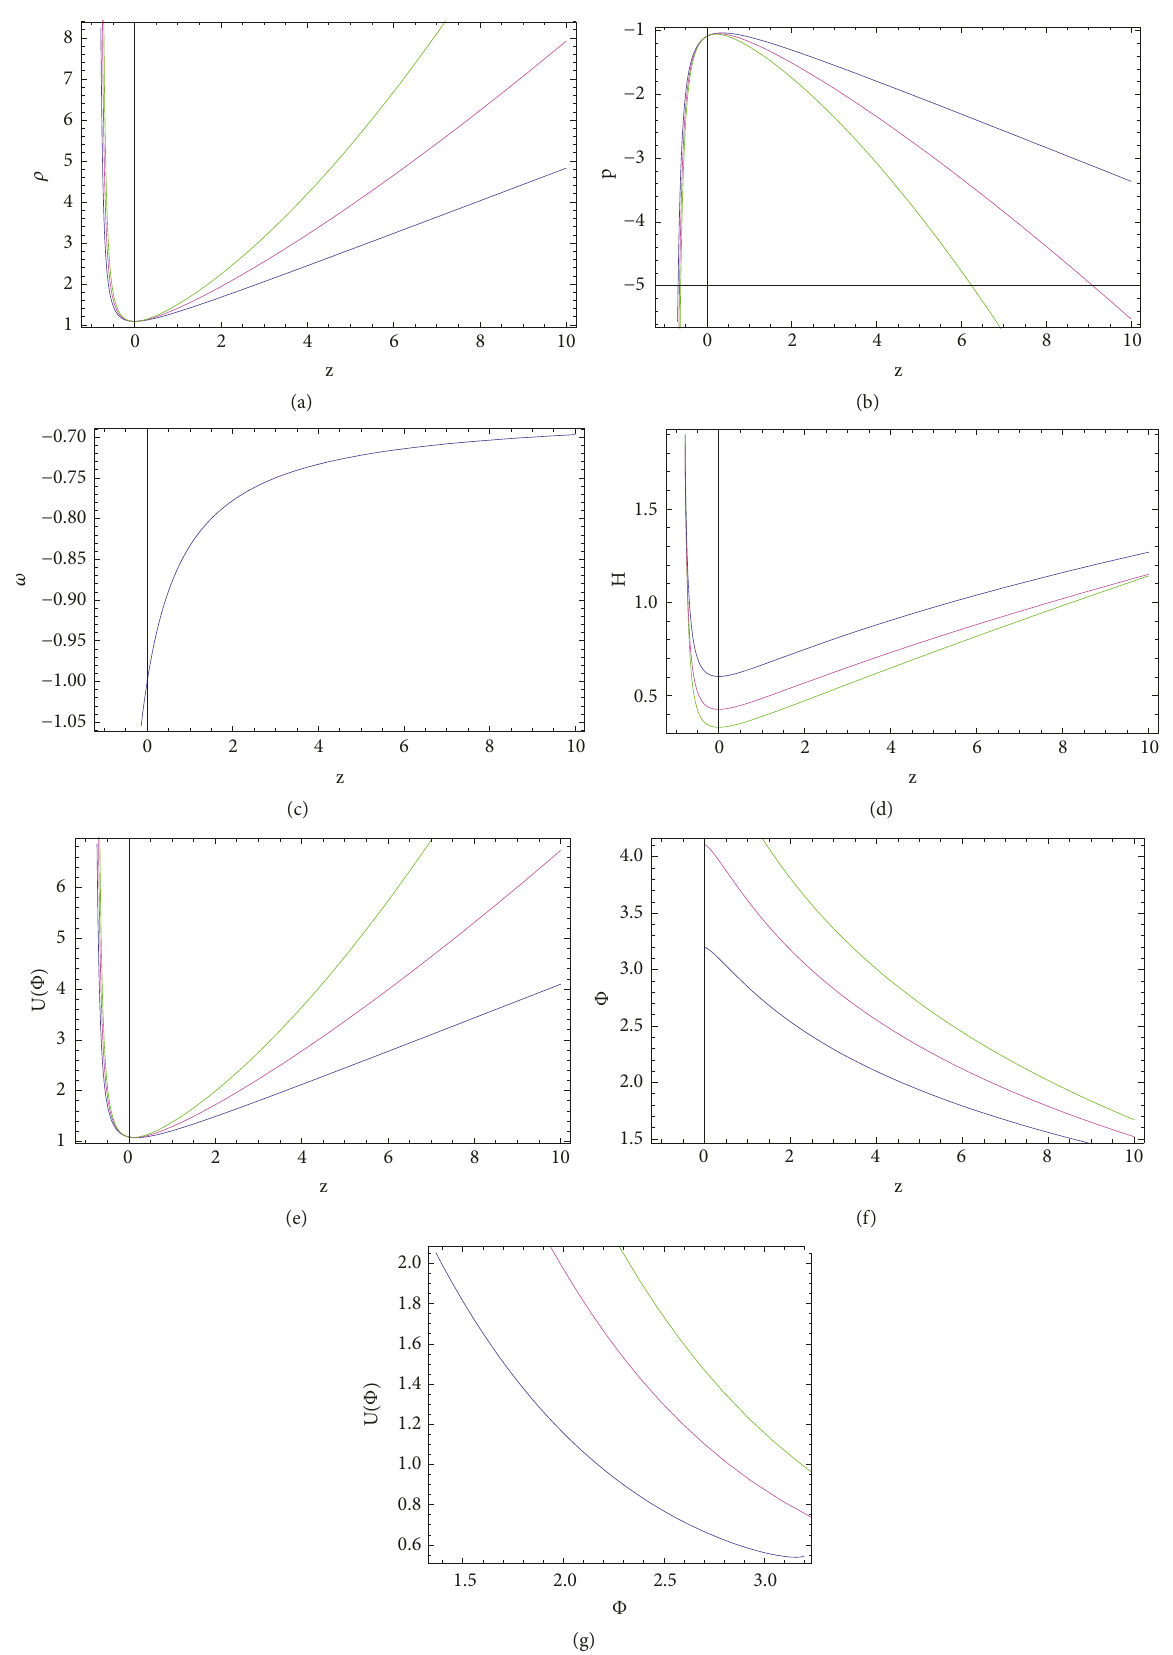
Figure 2: (a), (b), (c), (d), (e), and (f) show the variation of energy density 𝜌 , pressure 𝑝 , EoS parameter 𝜔(𝑧) , Hubble parameter 𝐻 , potential 𝑈(𝜙) , and the scalar field 𝜙 with the variation in 𝑧 for the CPL parameterizations. (g) shows the variation of 𝑈(𝜙) with 𝜙 . Different colored paths are obtained for different values of